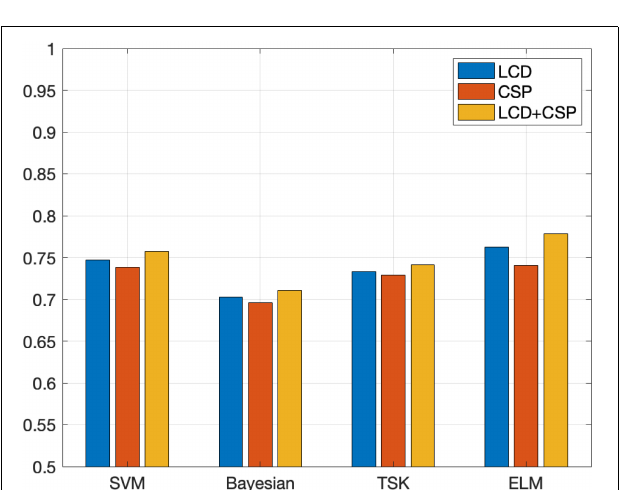
FIGURE 5 | Kappa coefficient obtained by each classification model on the Data Sets IIb.